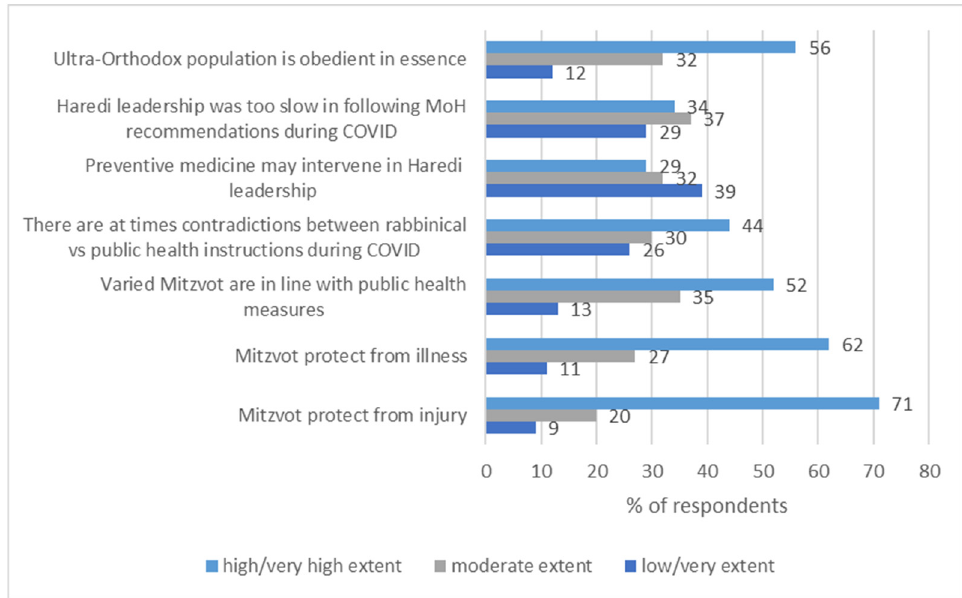
Figure 1. Beliefs and perceptions of ultra-Orthodox respondents concerning religion and public health measures to mitigate COVID-19 infection, in percentages ( N = 405).